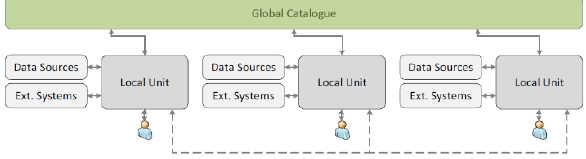
Figure 2: HEIMDALL Federation of Data and Services. Source: (HEIMDALL consortium, 2017).